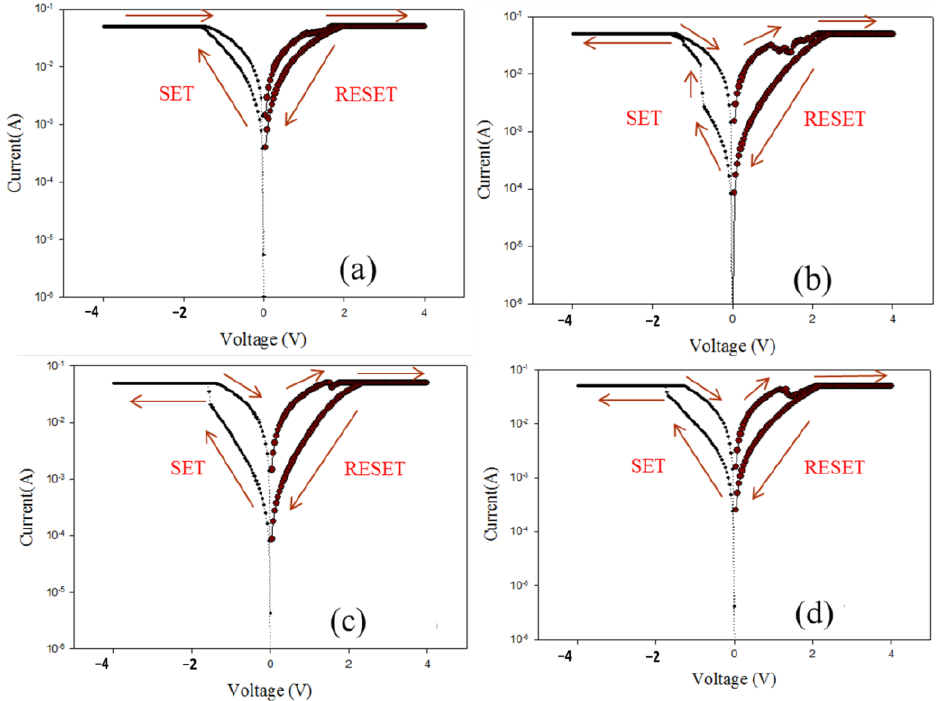
Figure 8. The I-V curves of ITO/ITO X /ITO RRAM under different oxygen growth procedure parameters for ( a ) 0%, ( b ) 25%, ( c ) 50%, and ( d ) 75%.